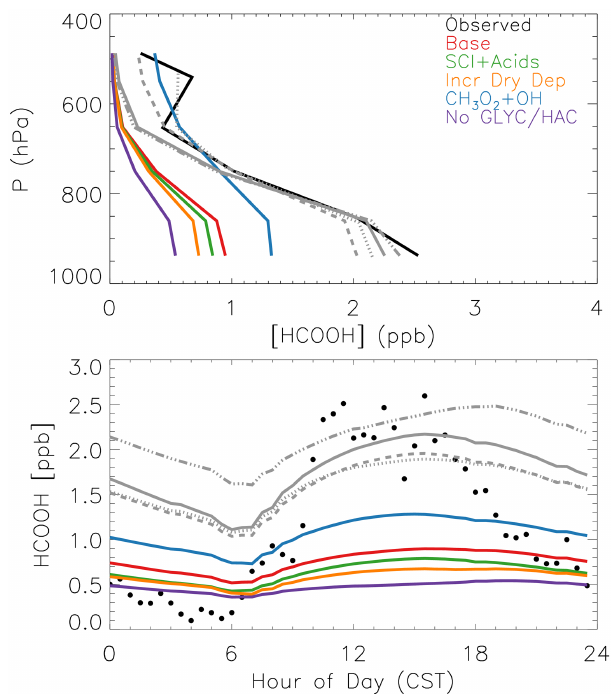
Figure 12. Sensitivity of atmospheric HCOOH to selected sources and sinks in GEOS-Chem. Shown in black is the mean HCOOH vertical profile observed during SENEX (top panel) and the mean HCOOH diurnal cycle observed during SOAS (bottom panel). Colored lines show the corresponding simulated amounts from GEOS-Chem for selected sensitivity runs described in the text. Base: base-case simulation; SCI + Acids: including reactions be- tween SCIs and carboxylic acids (Welz et al., 2014); Incr Dry Dep: setting the HCOOH dry deposition velocity equal to that of HNO 3 ; CH 3 O 2 + OH: including reaction between CH 3 O 2 and OH (Bosso- lasco et al., 2014) with a 100% yield of CH 2 OO; No GLYC/HAC: excluding HCOOH from isoprene-derived glycoaldehyde and hy- droxyacetone. Grey lines show example model adjustments that can fit the mean observed SENEX profile. Solid grey: scaled source from isoprene oxidation (3 × base-case); dot-dashed grey: scaled source from direct biogenic emissions (26 × base-case); dotted grey: scaled source from isoprene (1.8 × base-case) combined with a ubiquitous chemical source of HCOOH; dashed grey: scaled source from isoprene (2.3 × base-case) combined with a 56% CH 2 OO yield from CH 3 O 2 + OH. See text for